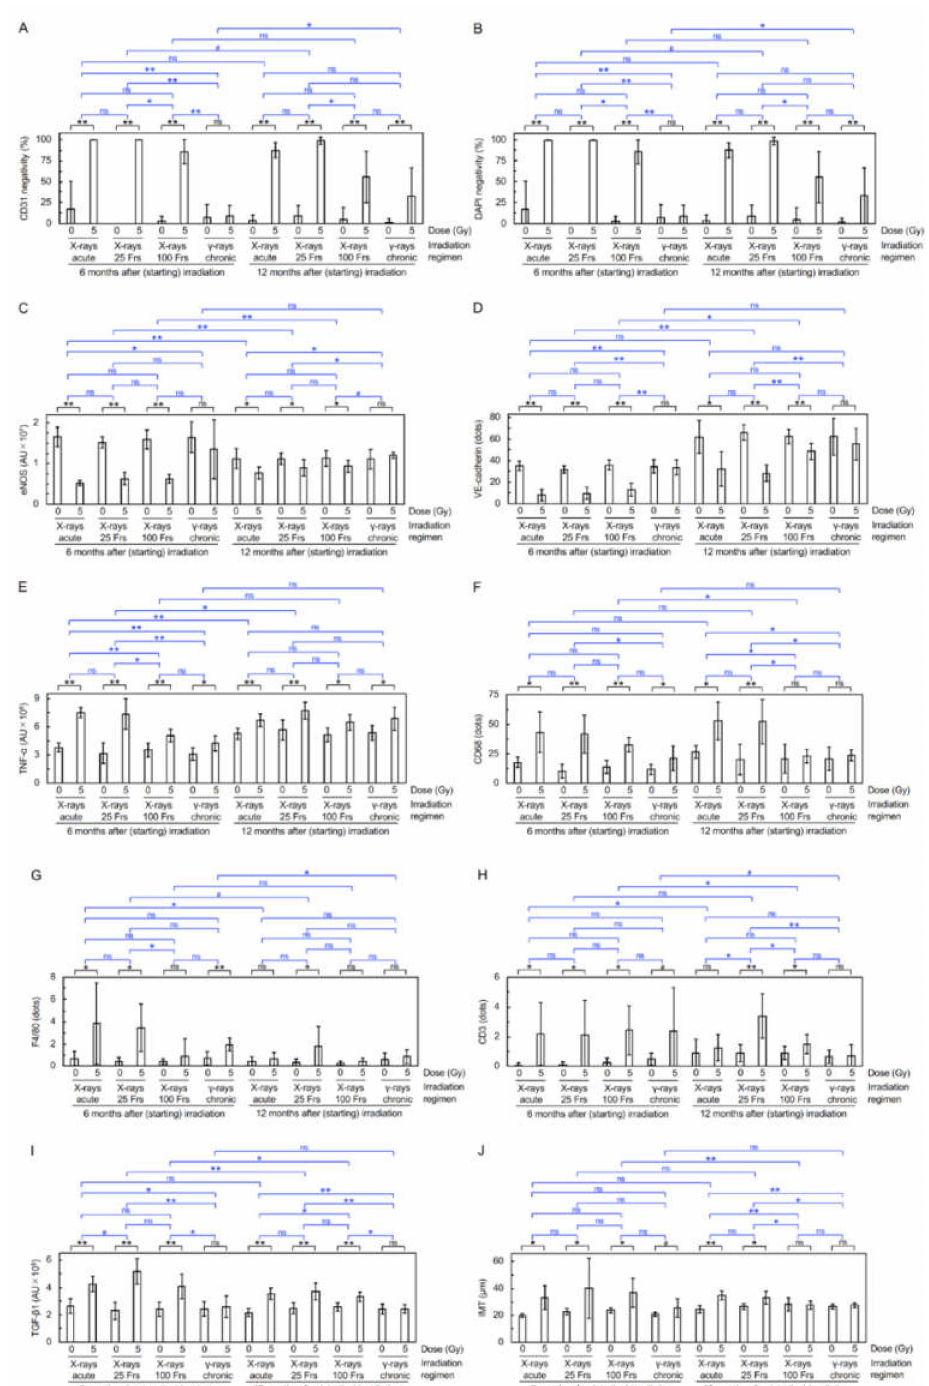
Figure 3. Molecular alterations in the aorta. Quantitative analysis of immunofluorescence for ( A ) CD31 negativity, ( B ) DAPI negativity, ( C ) eNOS, ( D ) VE-cadherin, ( E ) TNF- α , ( F ) CD68, ( G ) F4/80, ( H ) CD3, ( I ) TGF- β 1, and ( J ) IMT (8–10 mice/group analyzed, Welch’s t -test or Wald test). **, p < 0.001. *, 0.001 ≤ p < 0.05. #, 0.05 ≤ p < 0.1 (marginally significant). ns, p ≥ 0.1 (nonsignificant). See